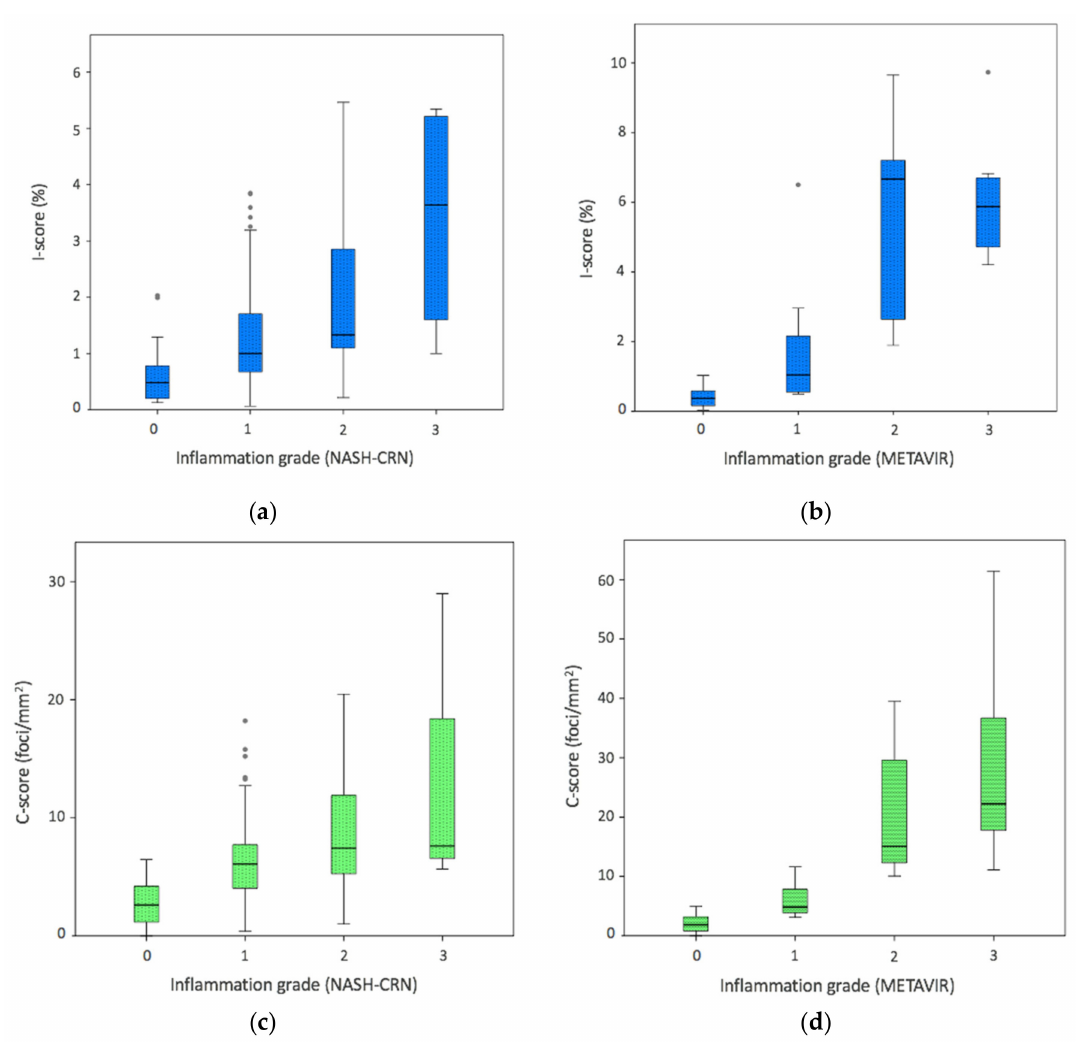
Figure 2. Distribution of digital pathology data across necroinflammatory activity histological scores. Boxplot of ( a ) I-score in NAFLD cohort, ( b ) I-score in chronic hepatitis cases, ( c ) C-score in NAFLD, and ( d ) C-score in chronic hepatitis. Blue boxes correspond to I-score (%CD45+) and green boxes to C-score (clusters proportion)